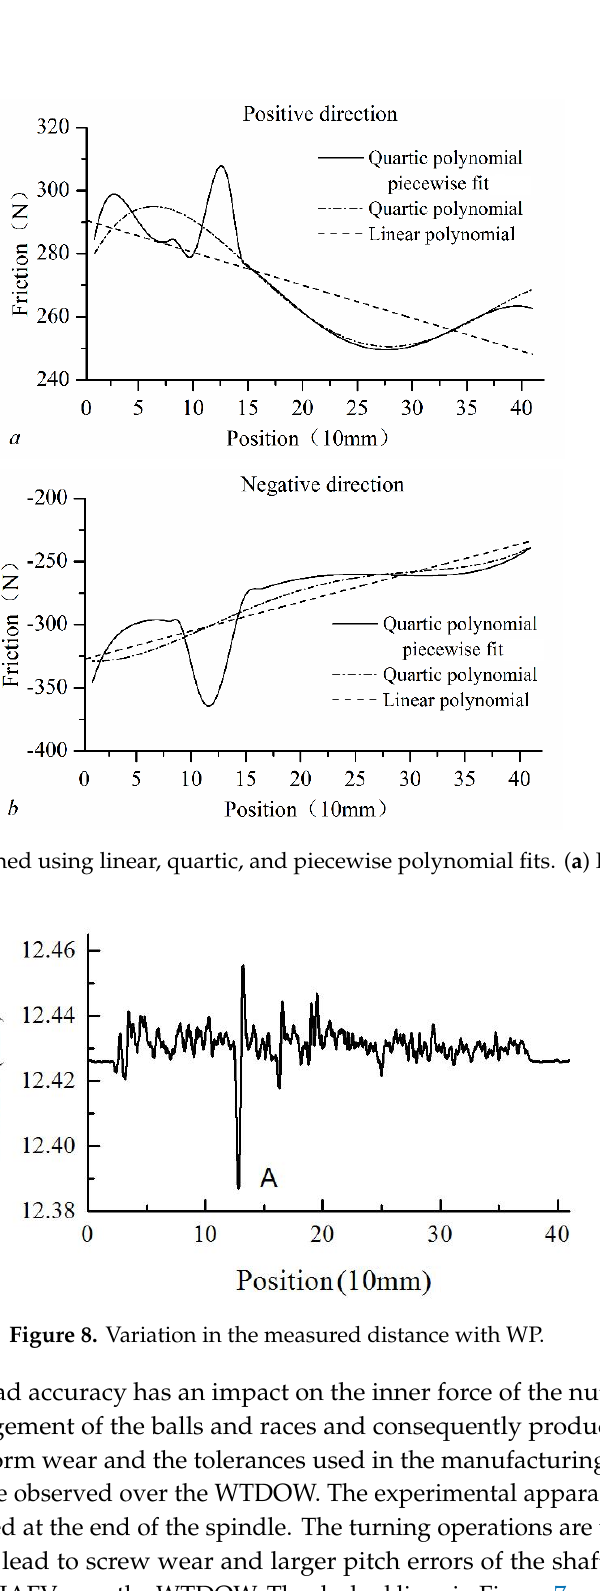
Figure 8. Variation in the measured distance with WP.